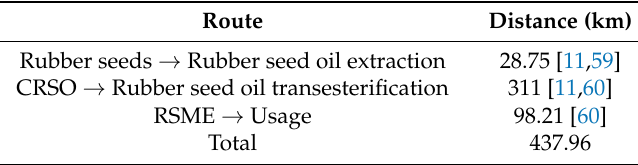
CRSO: crude rubber seed oil; RSME: rubber seed methyl ester .